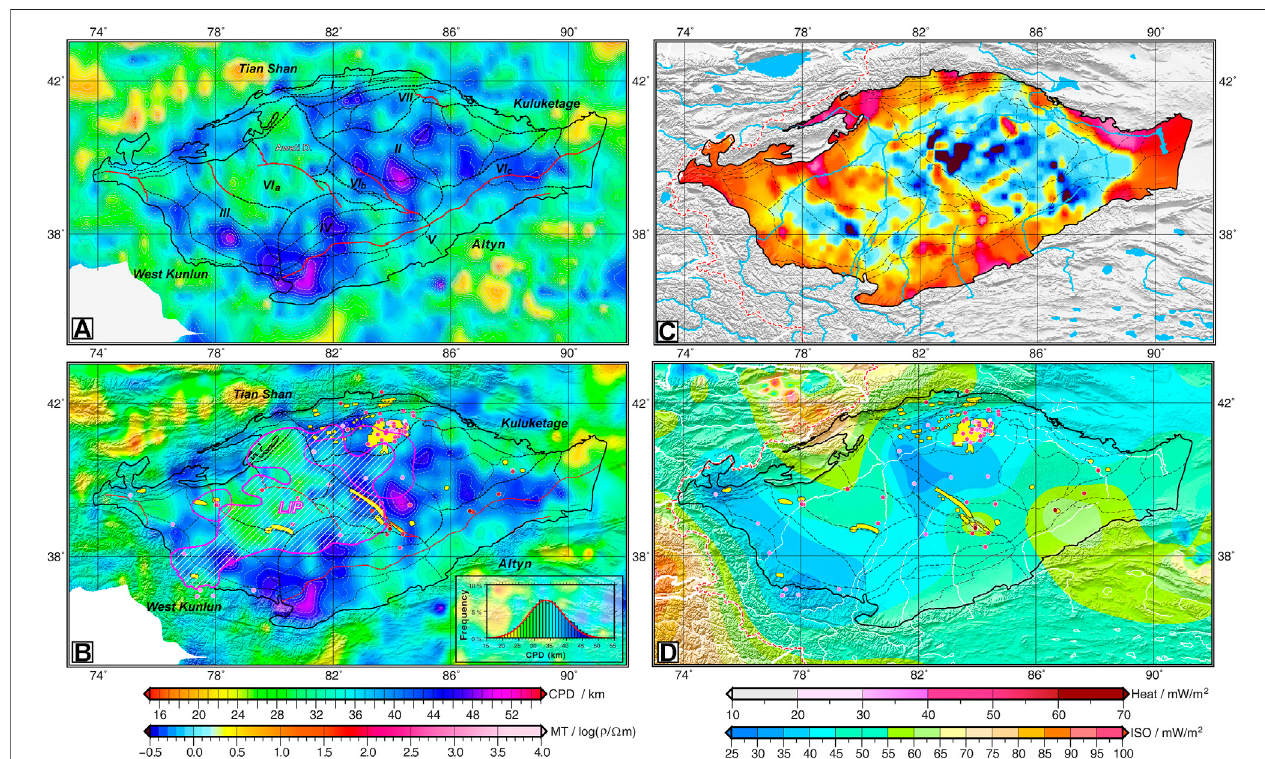
FIGURE6|(A) Shaded CuriesurfaceofTarimBasinand itsenvironsand (B) CPDlateral variationinthedigitalelevation model. Theredlines aremajorfaultswithin the basin. The purple line represents the Tarim Large Igneous Province (TLIP), modi fi ed from Yang et al. (2007). The Yellow patches are the oil and gas fi elds. Abbreviations are as follows: LIP, Large Igneous Province; Awati D., Awati Depression. The frequency histogram showing the variations in Curie depths with Gaussian distributionestimatedbythisstudyillustratedinthelowerrightcornerofFigureB.TheCPDmapisoverlainontheshadedETOPOmodel.NotethattheCPDvalues in the southwestern corner of the map must be clipped due to the existence of a missing-data area and following an unreasonable continuous CPD interpolation for the data blank, re fl ecting the unrealistic characteristics of geological units. (C) Spatial variations of electrical resistivity (MT) at 2 km depth overlay on the digital elevation model within the Tarim Basin, originated from Yang et al. (2015). (D) Isogram of heat fl ow (ISO) in the elevation model in the Tarim Basin and its environs, derived from Jiang et al. (2019). The colored circles (Heat) distributed on the map are newest measured heat fl ow points, compiled from Jiang et al. (2019).